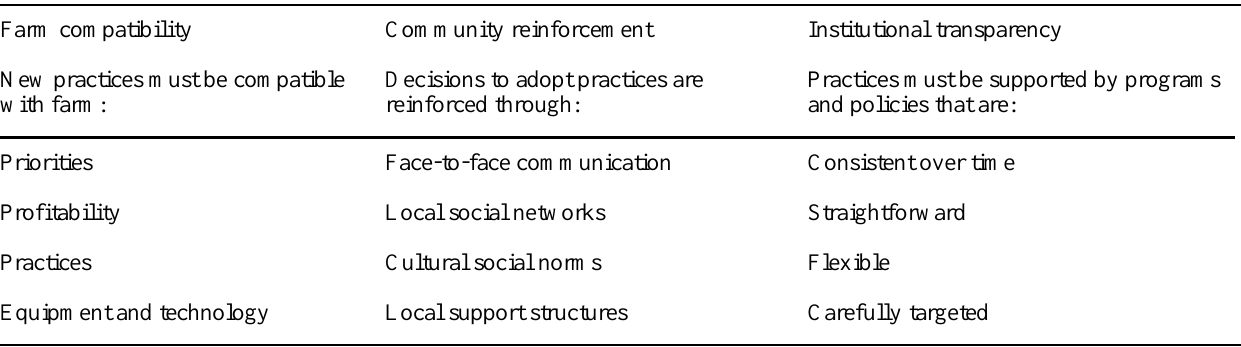
Table 2 . The 12 themes that arose from our interview data arranged into three classes: farm compatibility, community reinforcement, and institutional